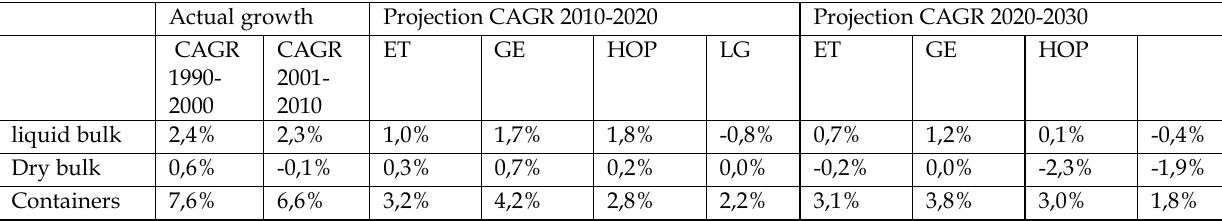
Table 6. HLH range compound annual growth rates (CAGR) per commodity group, for the past decades and projections until 2030